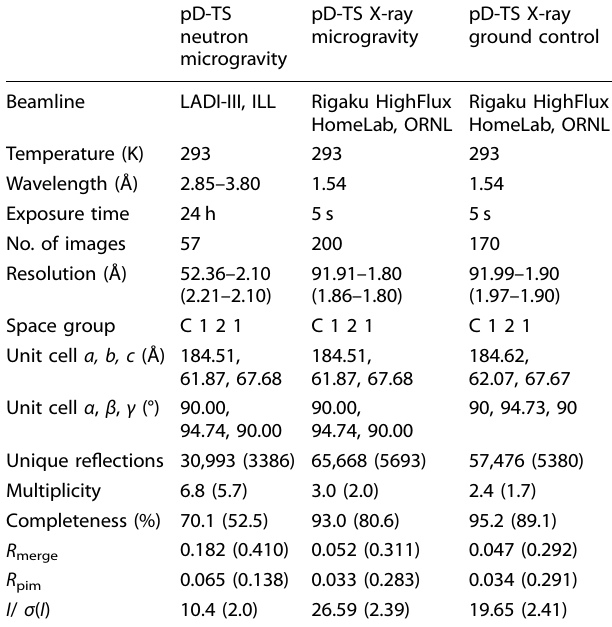
Table 1. Preliminary neutron and X-ray data collection statistics.